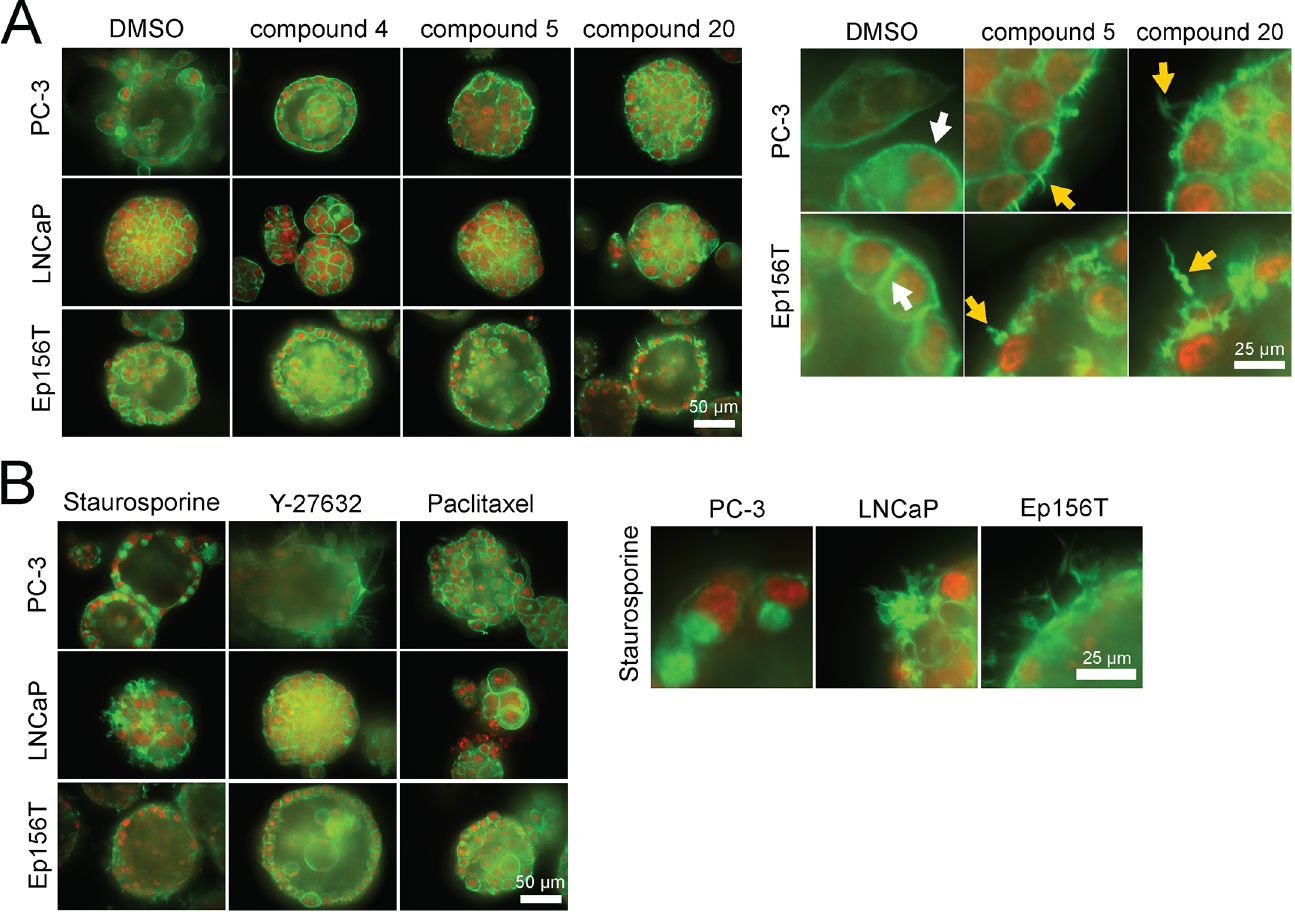
Fig 8. 3D morphologies of prostate spheroids, exposed to selected betulin derivatives and captured with a confocal microscope. Actin cytoskeleton (filamentous or F-actin) is stained green (phalloidin), nuclei with a red dye (confocal microscope images, 40× objective, scale bar shown for each panel on the right lower